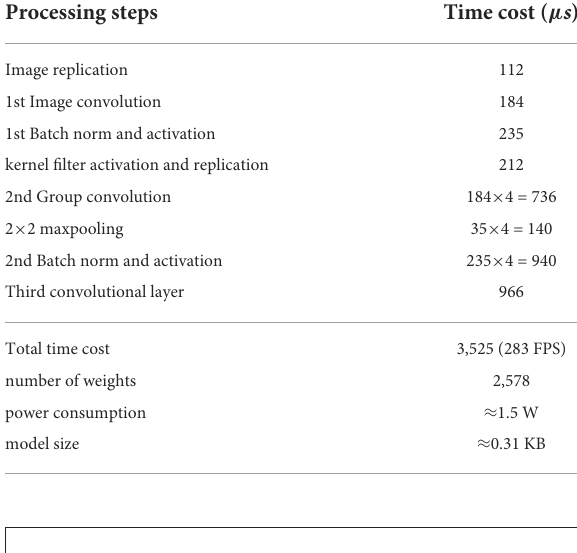
TABLE 3 Intersection over union (IoU) performance comparison between simulation and on the sensor for coarse segmentation. Task